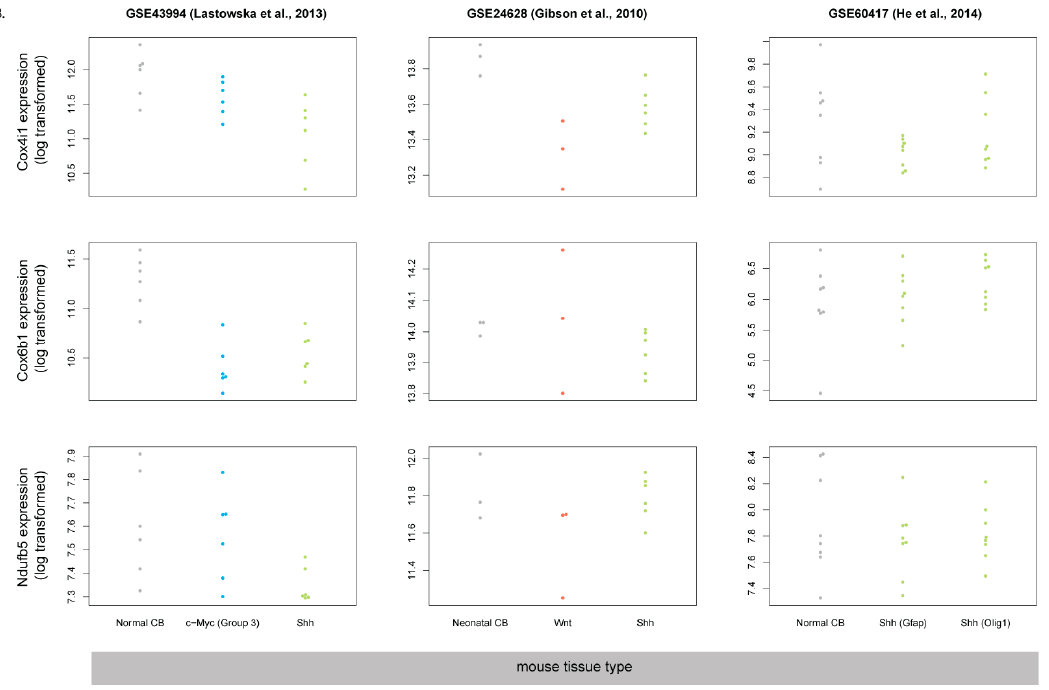
Figure 6. Mitochondrial respiratory chain genes are upregulated in human SHH-MB ( A ) but not in mouse Shh-MB ( B ). Expression data derived from microarray analysis were downloaded from GEO and processed as in Figure 2.